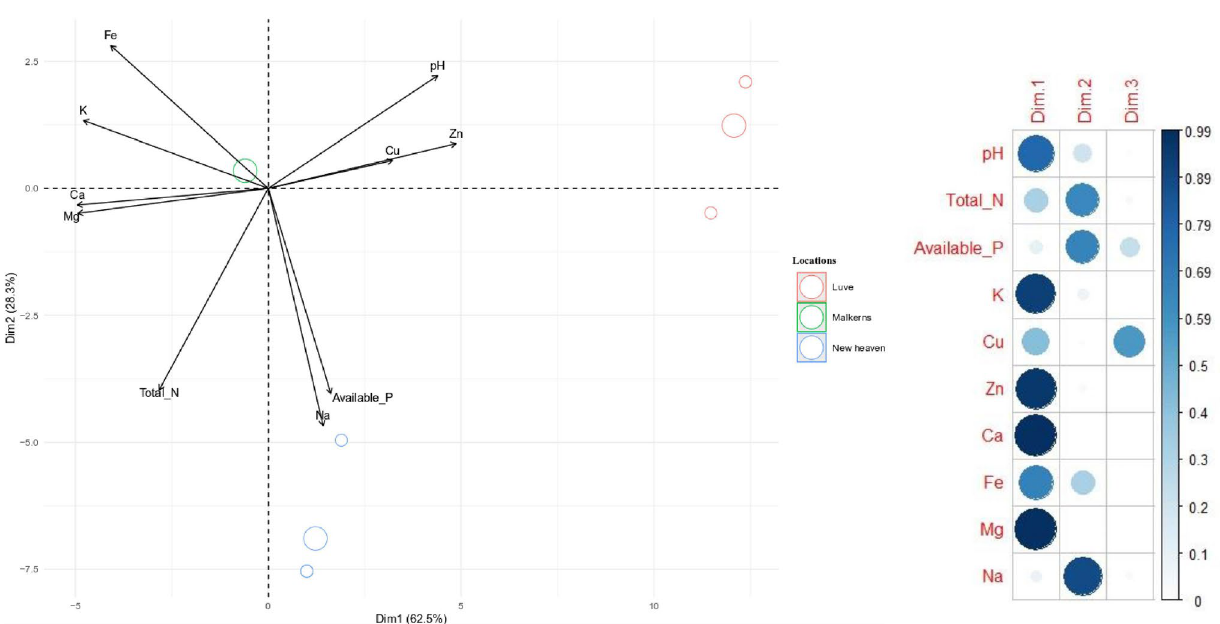
Figure 1. Dendrogram of ERIC-PCR fingerprints obtained from 76 rhizobial isolates from groundnut, jack bean and soybean from various locations in Eswatini.